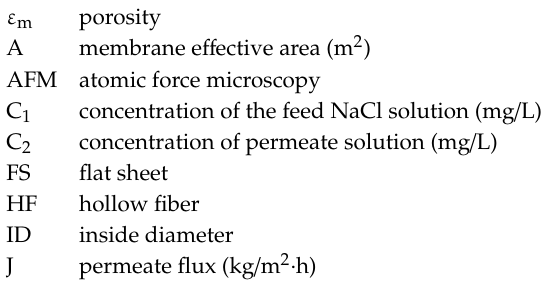
Table S1: Operating conditions versus permeate flux in SGMD